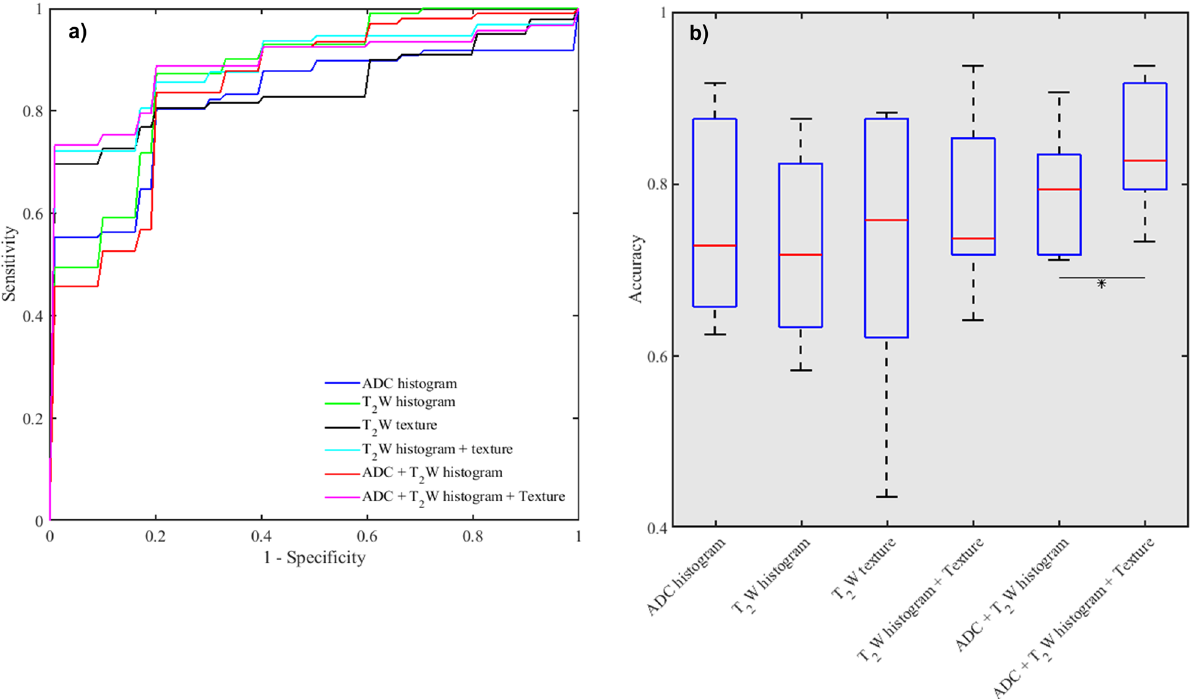
Figure 5. Performance of apparent diffusion coefficient (ADC), T 2 -weighted (T 2 W) histogram and T 2 W textual features in SVM classification of low-aggressive (grade group 1) versus intermediate/high-aggressive (grade group ≥ 2) prostate cancers. ( a ) Receiver operating characteristic curves showing the added value of T 2 W image textural features over traditional intensity histogram features alone. ( b ) Box plot comparing classification accuracies. * indicates significant